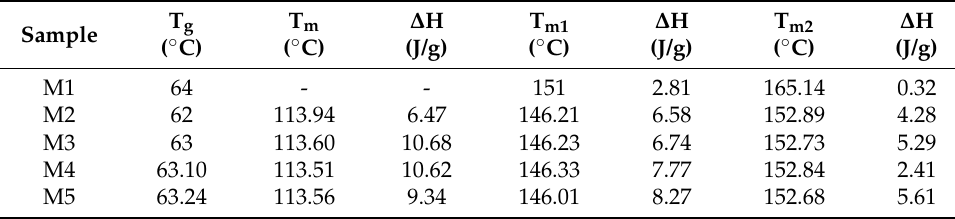
Table 4. DSC results of PLA, PLA-PBS, PLA-PBS-MCC